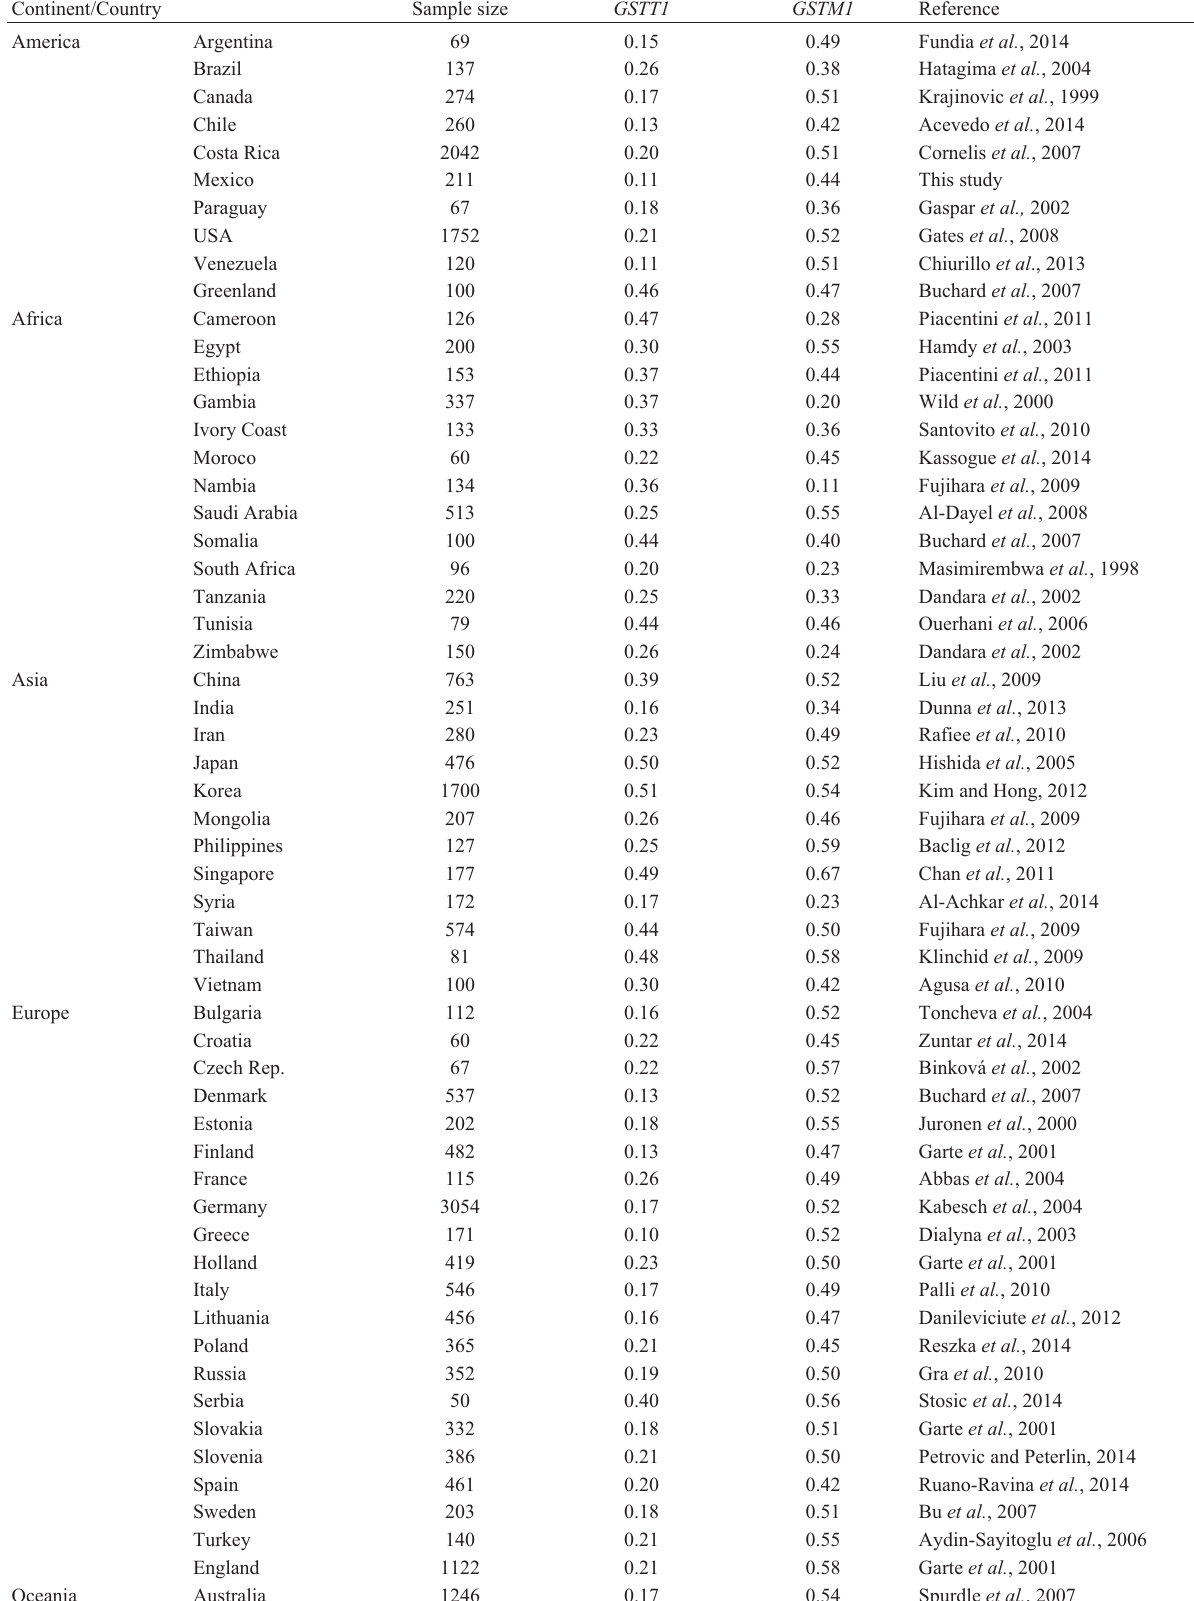
Table 2 - Frequencies of GSTT1 and GSTM1 null genotype in 57 countries worldwide.